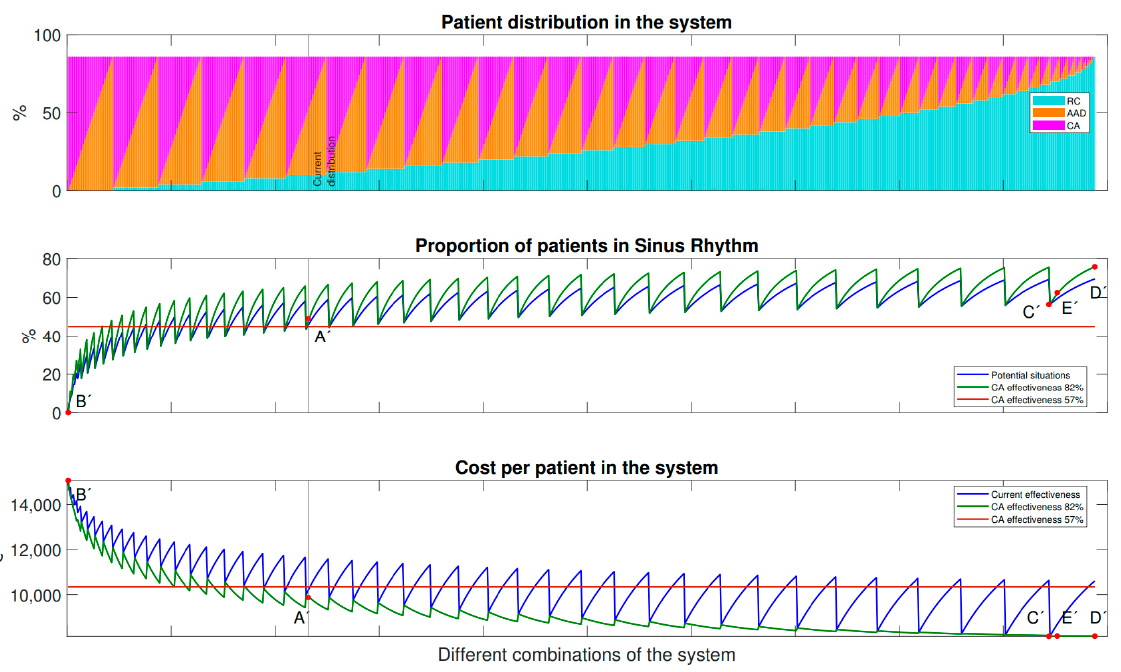
Figure 4. Variation of the distribution between the treatments with an increase of CA effectiveness of 25%. Table 4. Key values of potential situations after 5 years with the increase of effectiveness during CA due to the novel